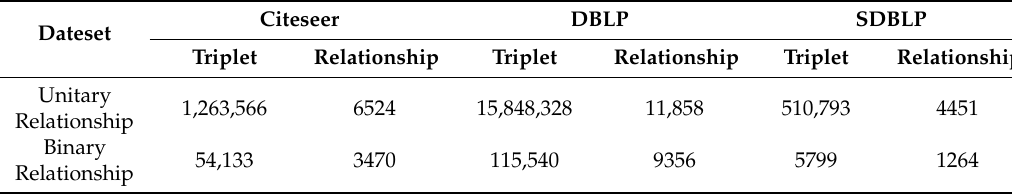
Table 3. Triplet and relationship count on the Citeseer, DBLP, and